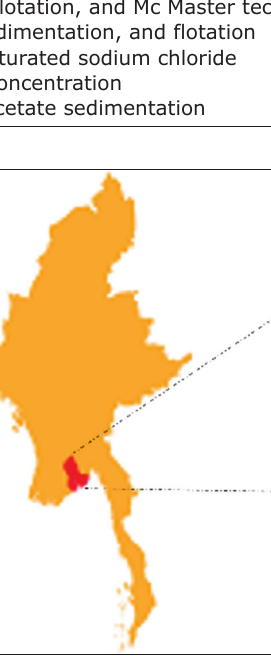
Figure-1: The map of Myanmar (left) and the location map of study area (Yangon region). (Raw map was sourced from https://en.wikipedia.org/wiki/